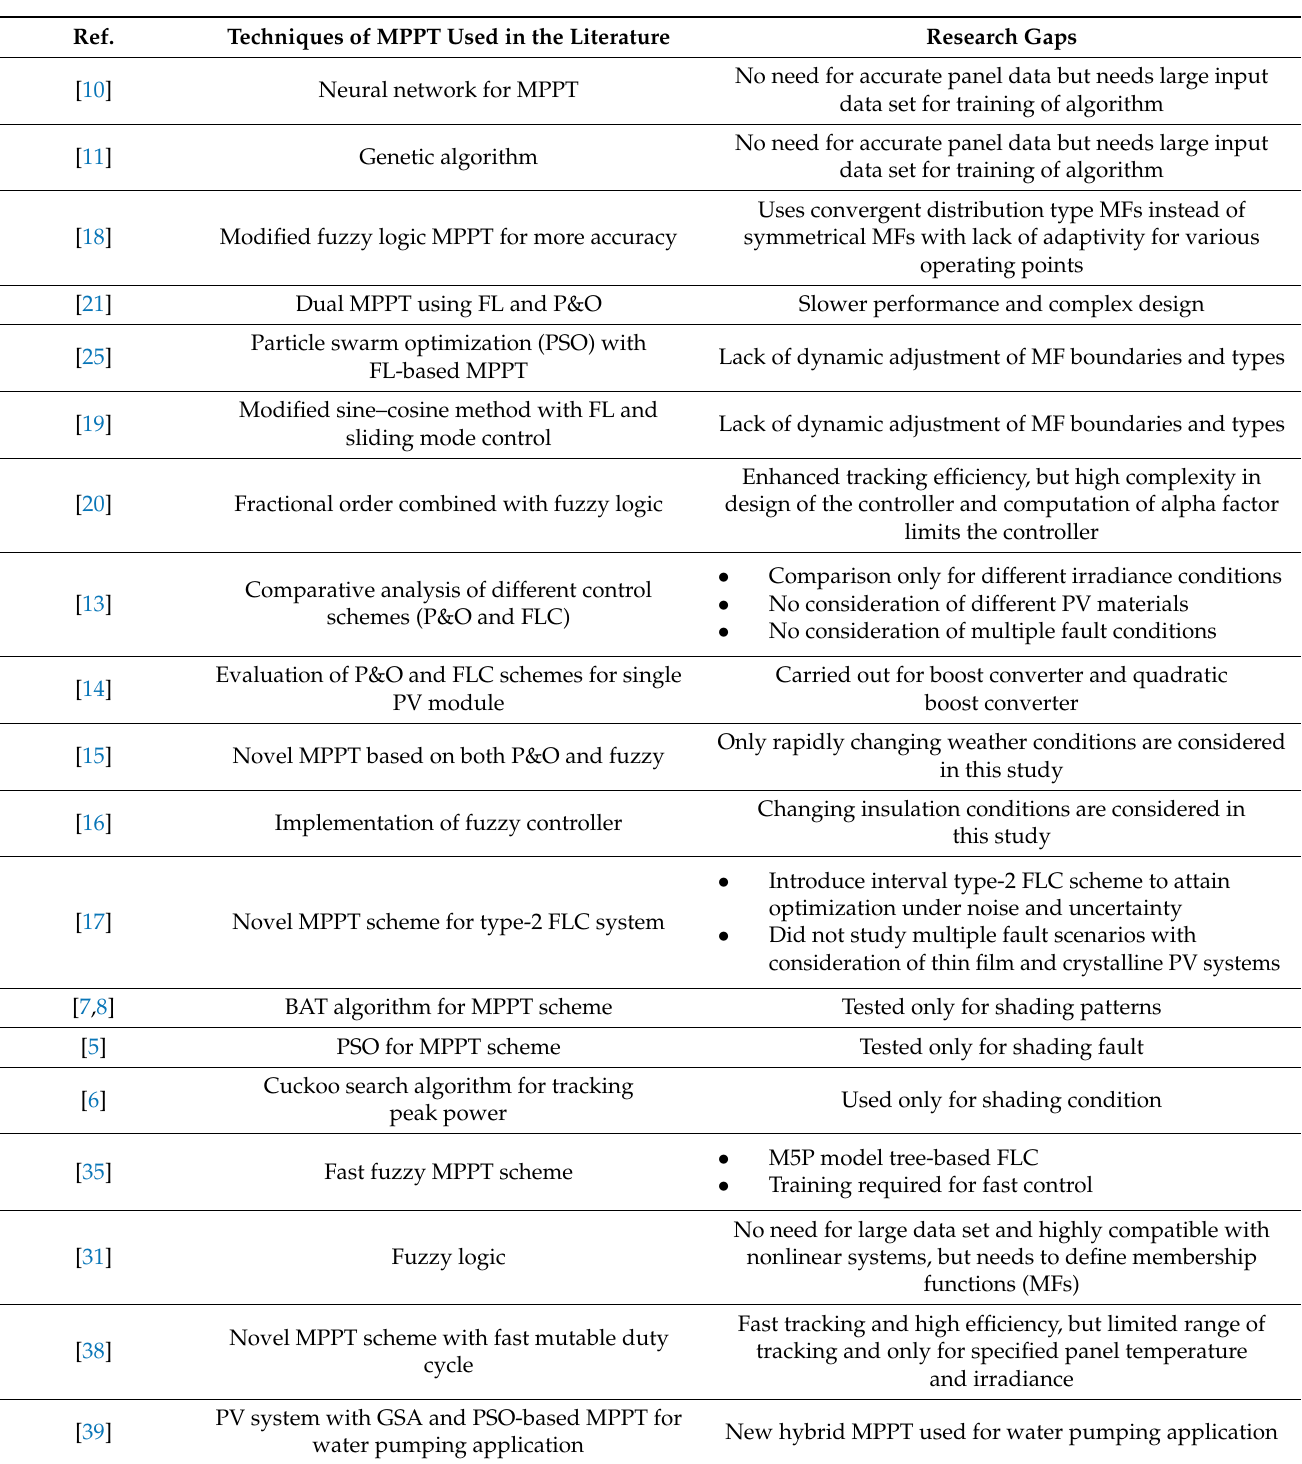
Table 1. Overview of existing literature with research gaps.